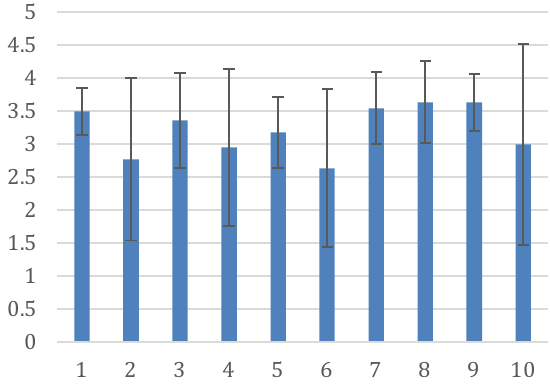
Figure 8 | Average SUS scores for the 10